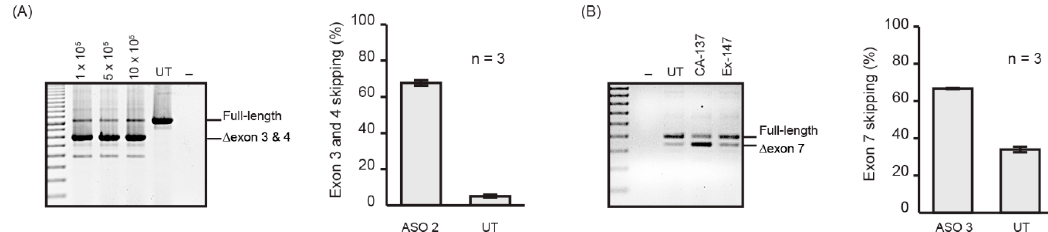
Figure 2. ( A ) RT-PCR products of ITGA4 transcript amplified from human fibroblasts nucleofected